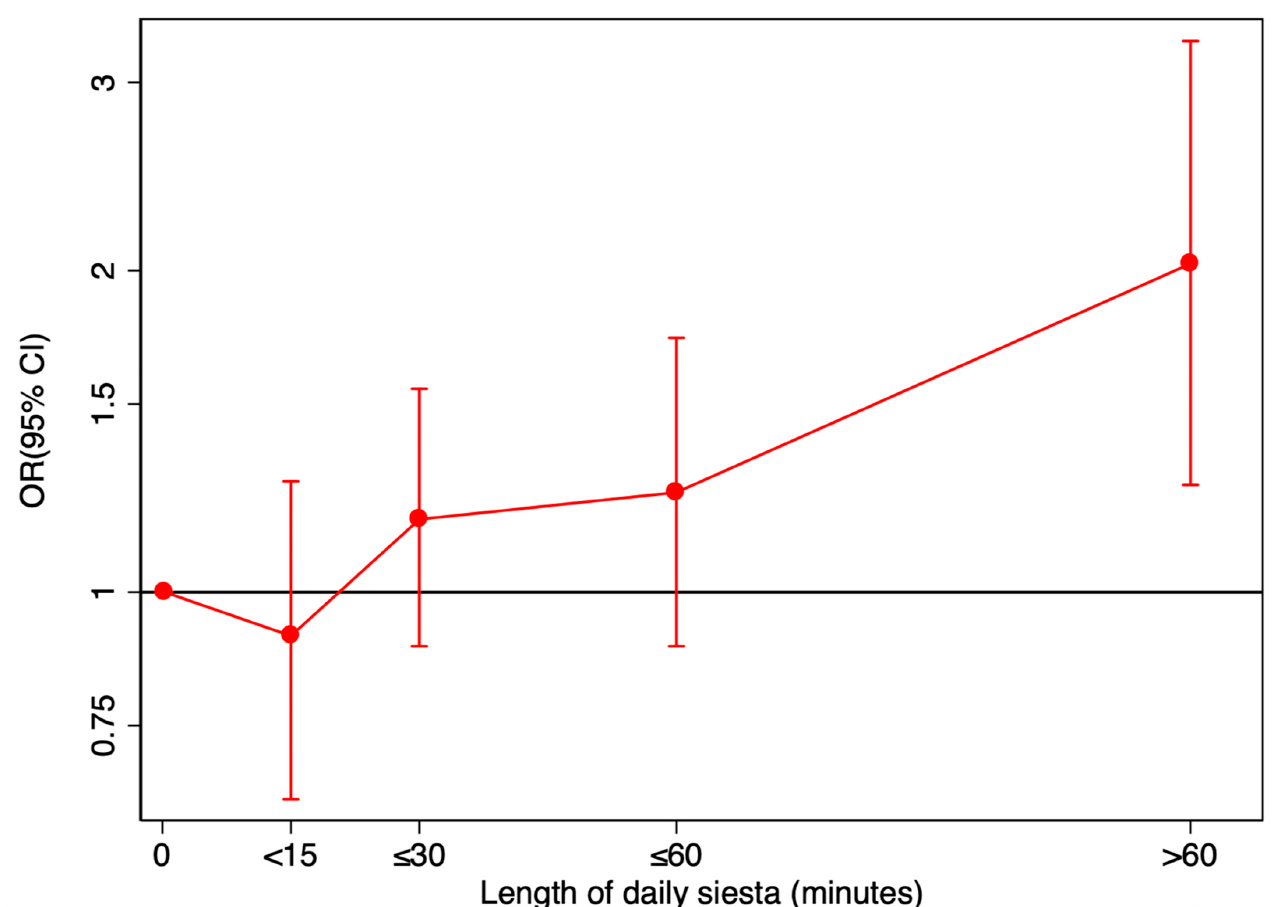
Figure 2. A non-linear relationship: Adjusted odd ratios (aOR) * and 95% confidence intervals (CI) for the development of metabolic syndrome according to length of daily siesta in the SUN cohort. * Adjusted for sex, age, years of university, year of entry into cohort, working hours, lunch at home, hours of night-time sleep, daily TV, smoking pack-years, daily alcohol intake, total daily energy intake, daily coffee intake, Mediterranean Diet Score, special diets, physical activity, social time, prevalent cardiovascular disease, prevalent cancer, prevalent depression, prior history of insomnia, obstructive sleep apnea, snoring, weight gain prior to recruitment, tendency to stress. Table 4. Analysis of effect modification: Adjusted odd ratios (aOR) * and 95% confidence intervals (CI) for the development of